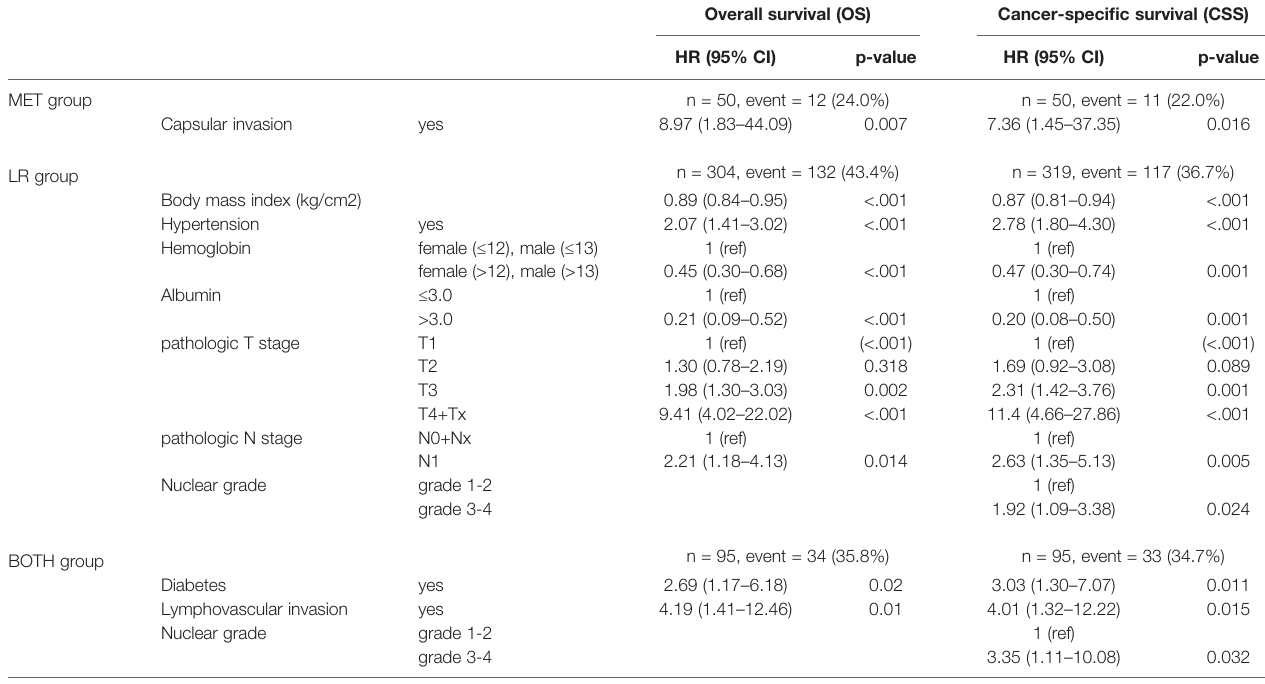
TABLE 3 | Multivariable Cox proportional hazard model in each subgroup for overall survival (OS) and cancer-speci fi c survival (CSS).